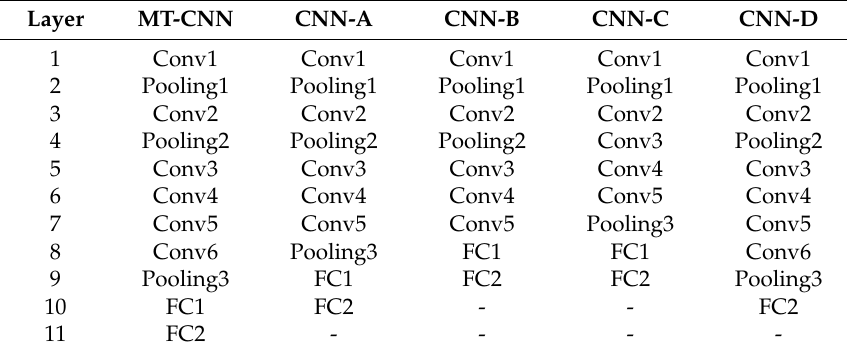
Table 10. Structures of five different CNN models.